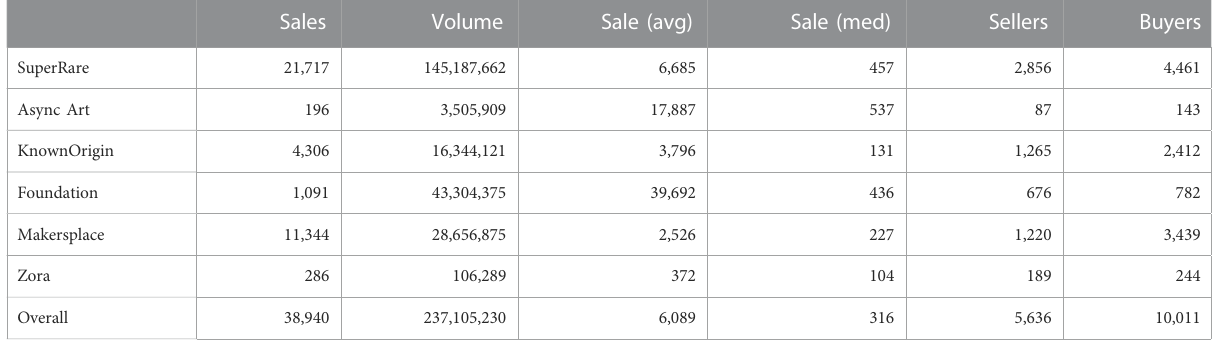
TABLE 1 Overview of the dataset per gallery. All sale values are in USD converted at the time of the sale.